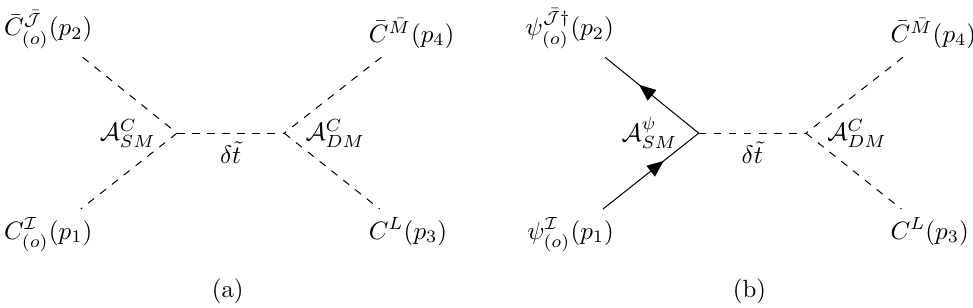
Figure 3. Possible chiral dark matter production mechanisms. The massive δ ˜ t modulus can be produced by scalar-scalar and fermion-fermion scattering in the thermal bath of particles in the observable sector created during reheating. Based on the expected mass spectrum shown in table 1 and the possible interactions between the observable sector thermal bath and the hidden sector fields, we identified the hidden matter scalars C L , L = 1 , . . . , N , as one of the plausible dark ( h ) ( h ) matter candidates within our theoretical